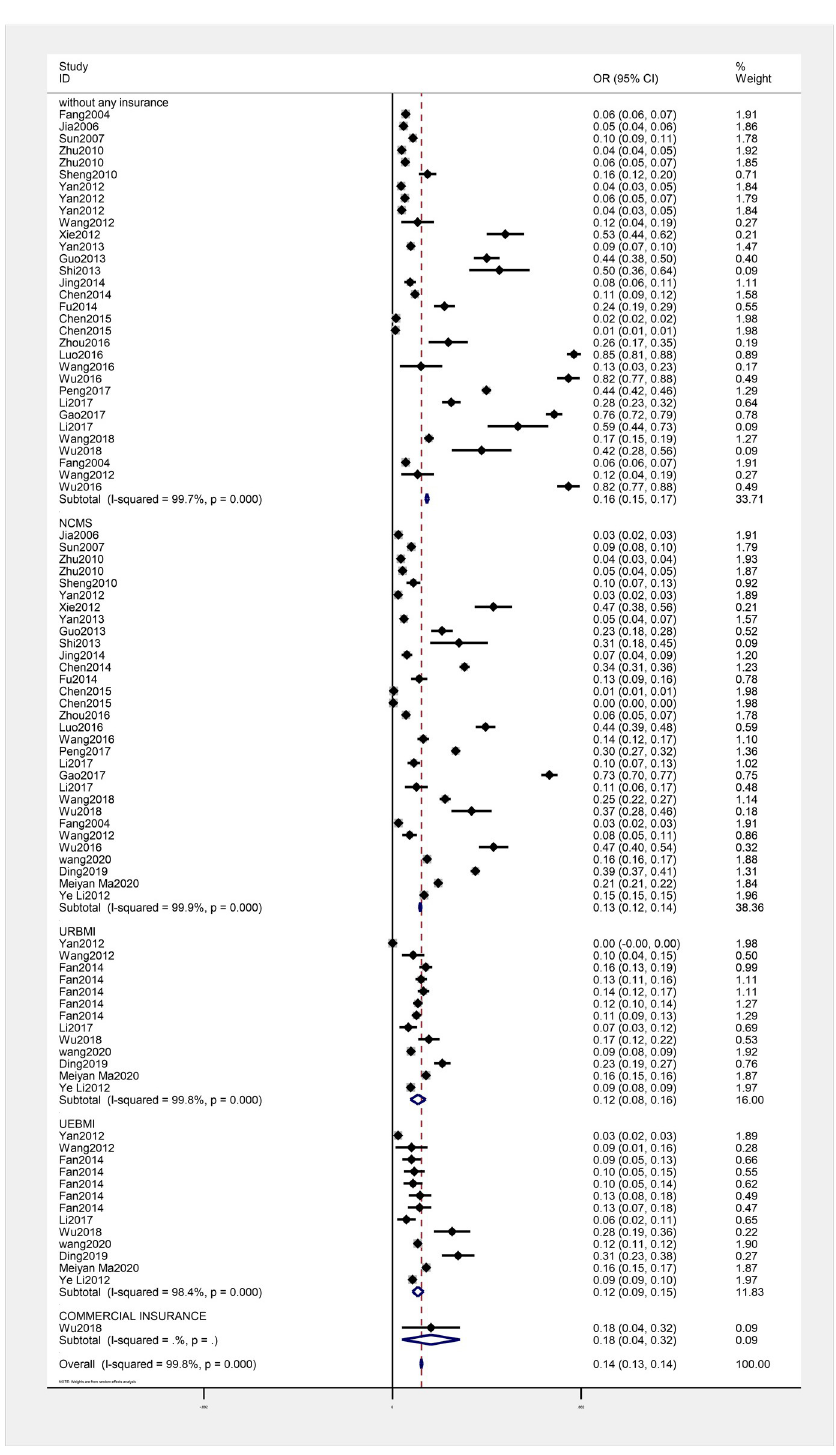
Fig 4. Rate of catastrophic health expenditure by types of health insurance.